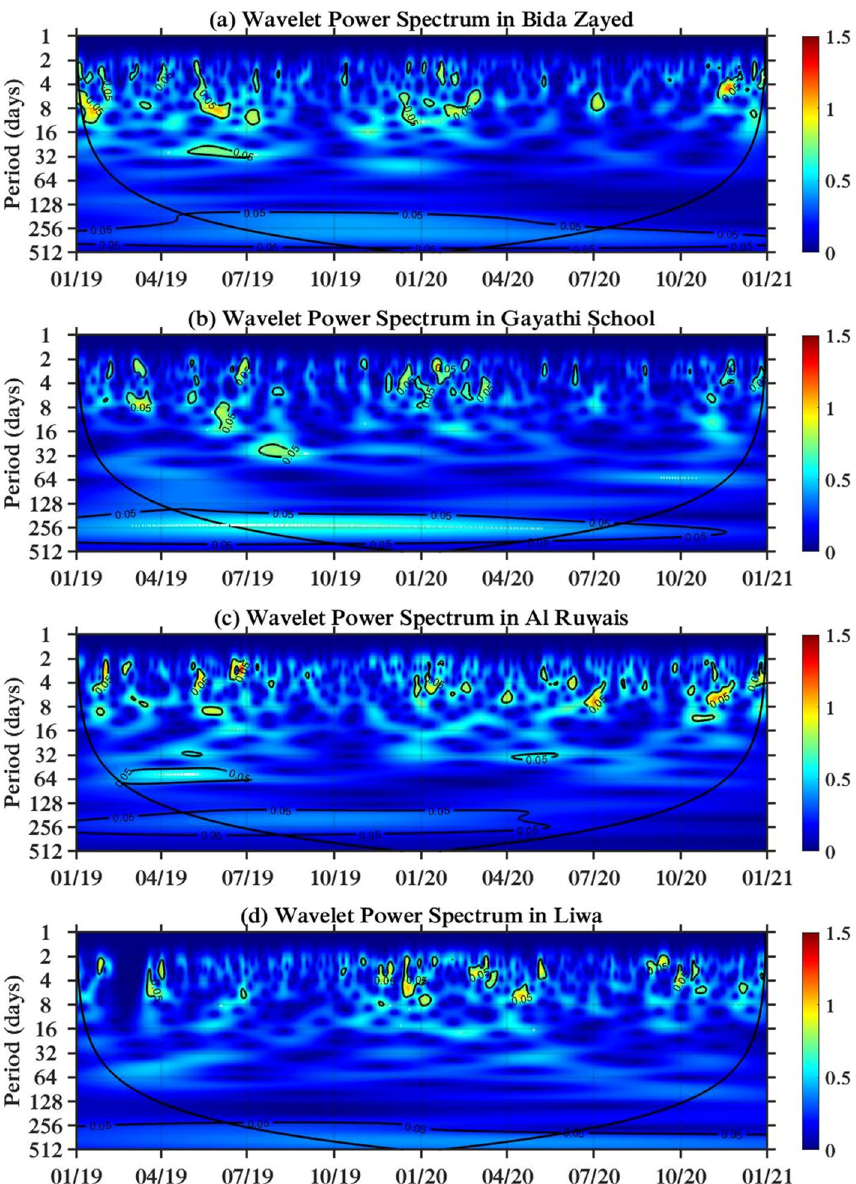
Figure 5. Wavelet power transform in the Al Dhafra region: ( a ) Bida Zayed, ( b ) Gayathi School, ( c ) Al Ruwais, and ( d )